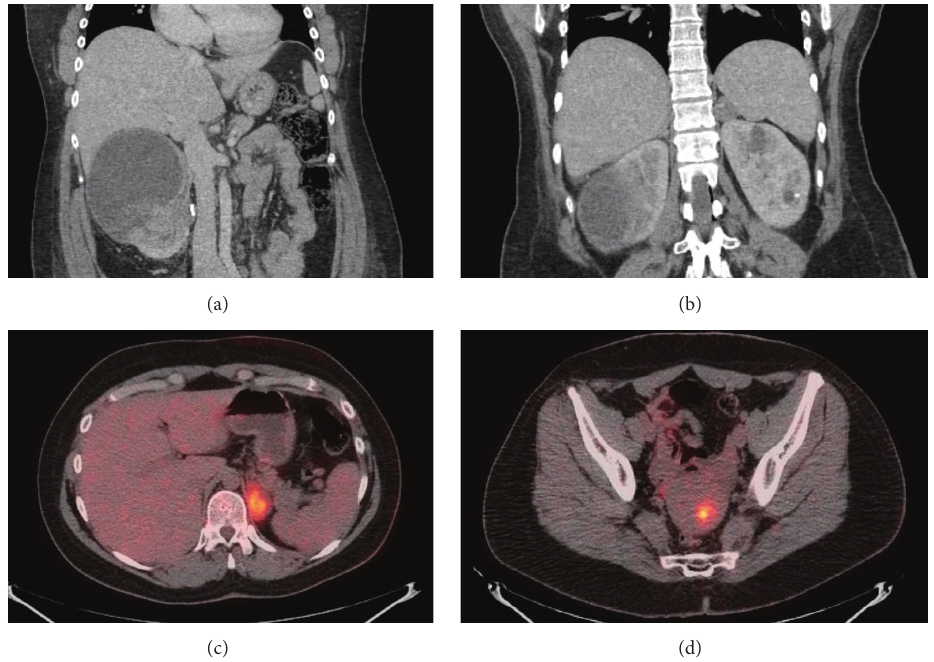
Figure 1: (a) CT representation of the right papillary type 2 renal cell carcinoma. (b) CT representation of multiple cystic structures within the left kidney. (c) PET scan demonstrating FDG-avid left adrenal lesion. (d) PET scan demonstrating FDG-avid uterine focus, likely a